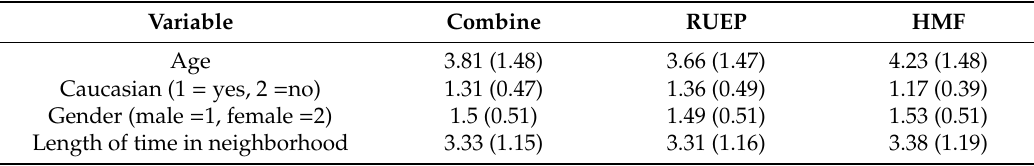
Table 1. Sociodemographic information for participants displayed by overall composition, as well as separated for those who lived near HMF and those near the RUEP. Average values are shown along with standard deviation in parenthesis.